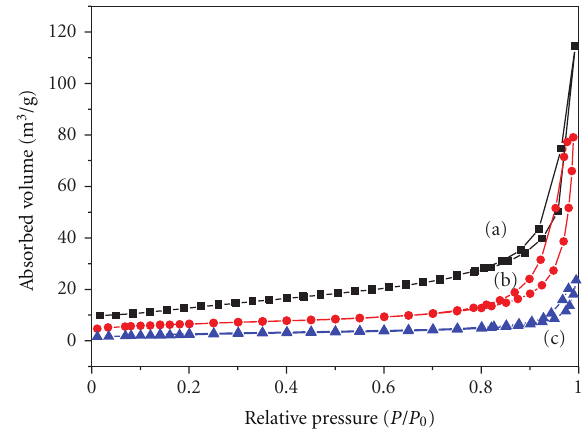
Figure 5: Nitrogen adsorption-desorption isotherms of the P25 powders before (a) and after calcination at 500 (b) and 700 ◦ C (c) for